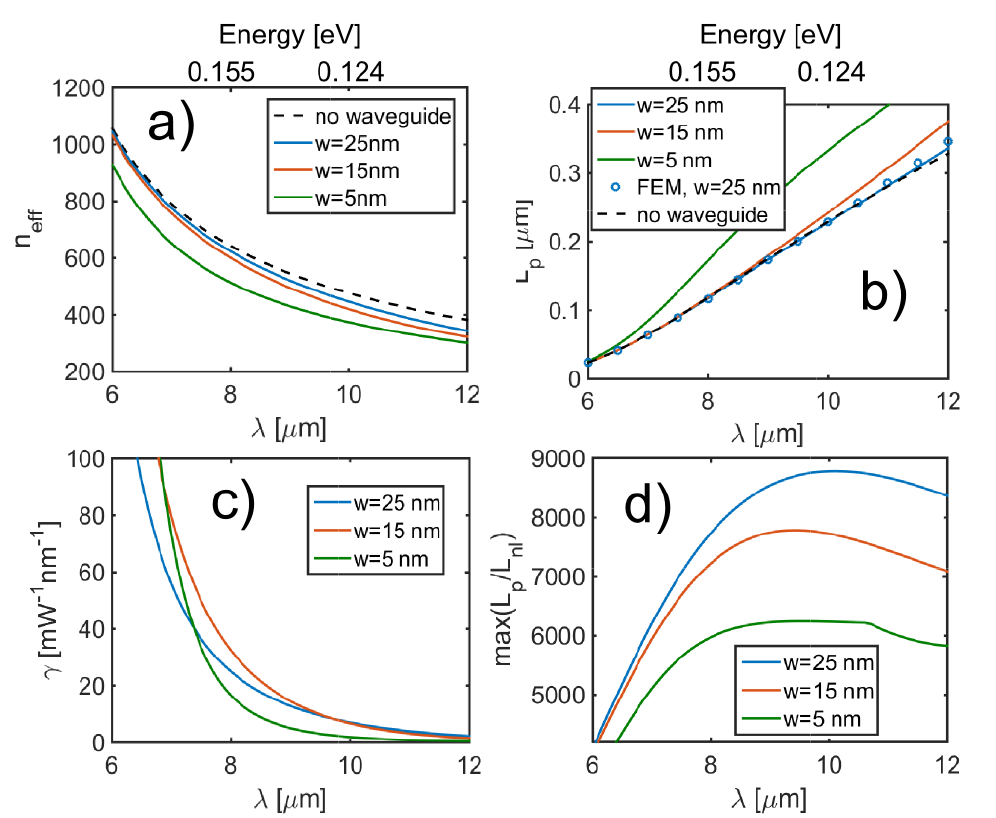
Figure 2. Linear and nonlinear parameters for GSP waveguides of different widths: effective index ( a ); attenuation distance ( b ); nonlinear coefficient ( c ); and the maximal ratio between nonlinear and attenuation distances ( d ). Dashed line in panels ( a , b ) indicate characteristics of the GSP on a homogeneous graphene sheet with σ ( b ) circles indicate attenuation length for w = 25 nm as computed directly from Comsol, see text for